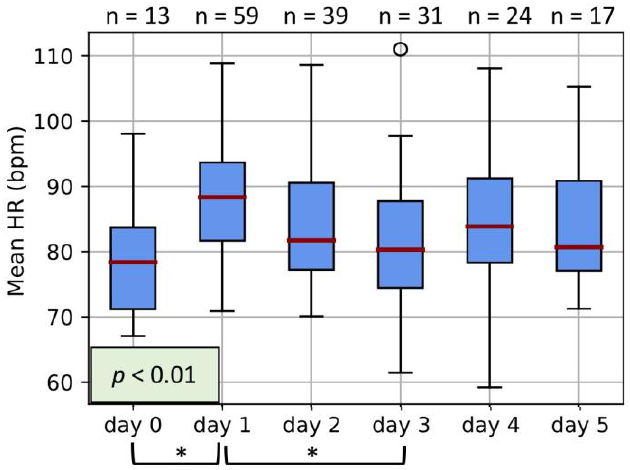
Figure 1. Boxplots of the HR of participants on days 0 to 5 . Boxplots represent the median, interquartile range, and interdecile range of the values. Day 0 represents measurements taken before the first injection of Betamethasone, while day 1 represents 24 h after the first injection, day 2 represents 48 h after the first injection, etc. * represents a statistically significant finding with p < 0.05. The number of measurements incorporated into each day is displayed at the top of the graph.